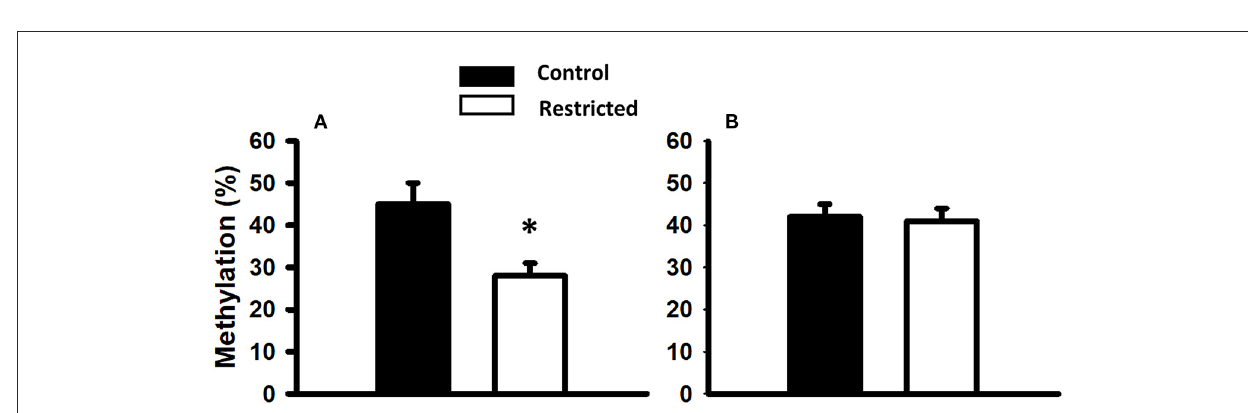
FIGURE6 Global DNA methylation of pancreatic islets from male rats at PND 36 (A) and PND 90 (B) born to mothers fed a control or protein-restricted diet during gestation. Data are expressed as the mean ± SEM from five rats/group. * P < 0.05 compared with control.